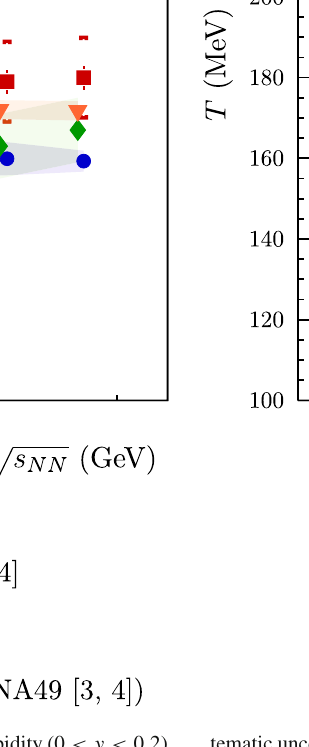
Fig. 13 Left: inverse slope parameter T at mid-rapidity (0 < y < 0 . 2) fittedintherange0 . 24 < m T − m π < 0 . 72GeVplottedagainstthecolli- sion energy per nucleon together with measurements for inelastic p + p , central Be+Be and central Pb+Pb collisions. Statistical uncertainties are shown as vertical bars (often smaller than the marker size) and sys- Fig. 14 The inverse slope parameter T versus the mean number of wounded nucleons (cid:5) W (cid:6) in central Ar+Sc collisions at beam momenta from 19 A to 150 A GeV / c . Statistical uncertainties are smaller than the marker size. Systematic uncertainties are shown by shaded bands. For better visibility different energies are offset